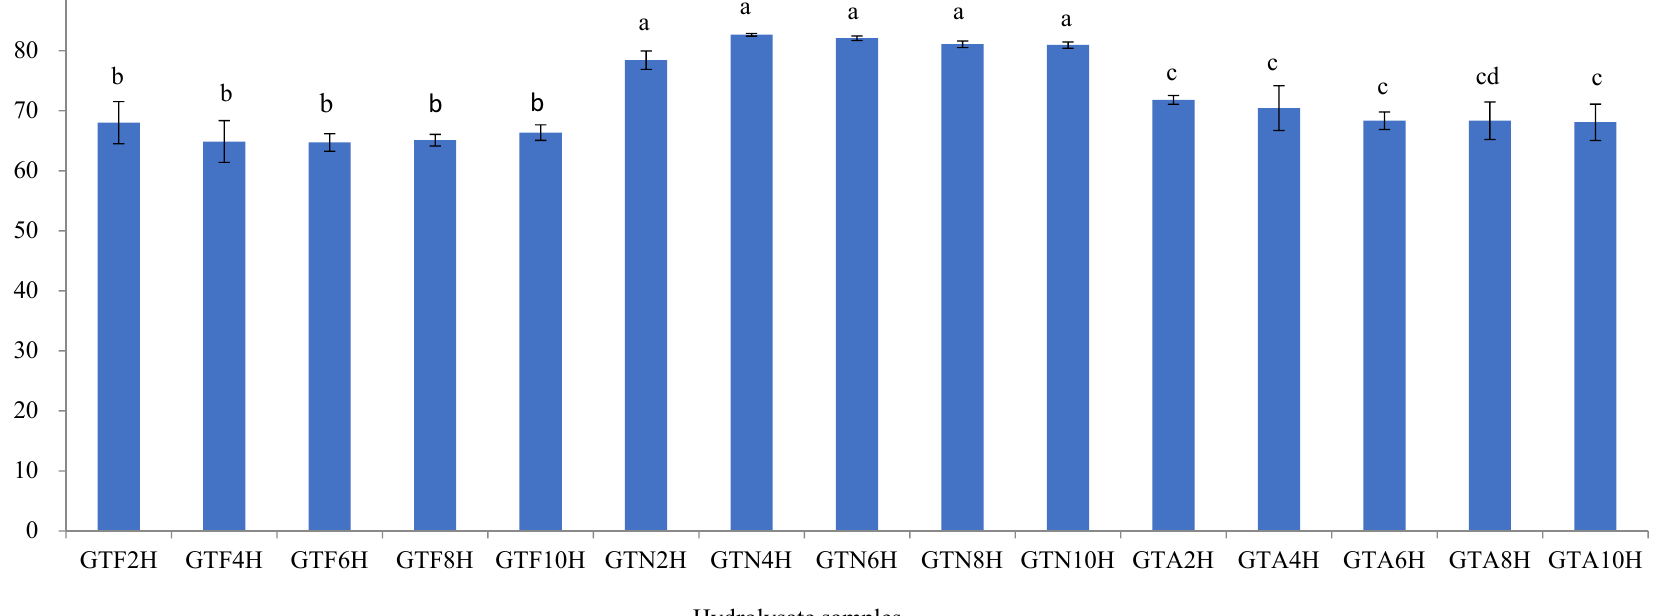
Figure 1. In vitro ACE-inhibitory activity of 10 mg/mL of protein hydrolysates from groups GTF, GTN, and GTA. Data represent mean ± SD ( n =3). The different lower-case letters are significant differences (p<0.05).